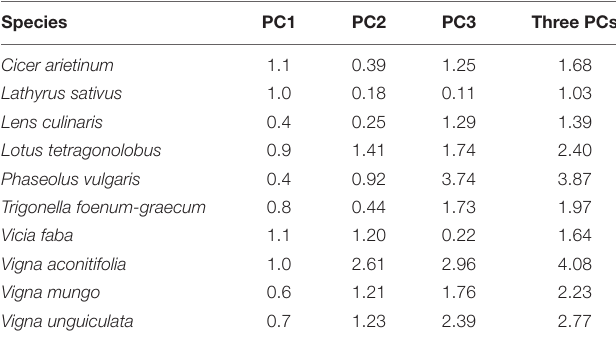
TABLE 3 | Euclidian distance between literature and current study coordinates of the barycenter of each species on the firsts three PCA axes. Species PC1 PC2 PC3 Three